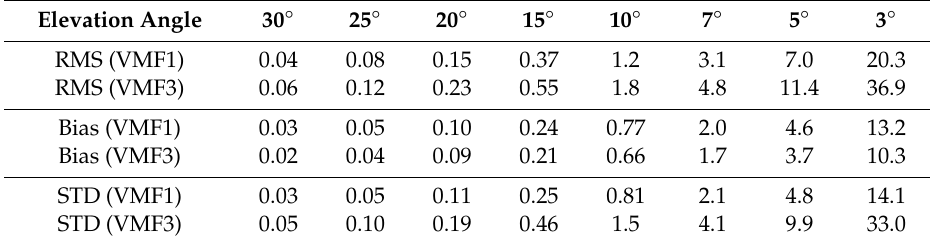
Table 6. Mean RMS, bias, and standard deviation for 28 stations, 3 years of wet VMF1 and VMF3 compared to radiosonde in